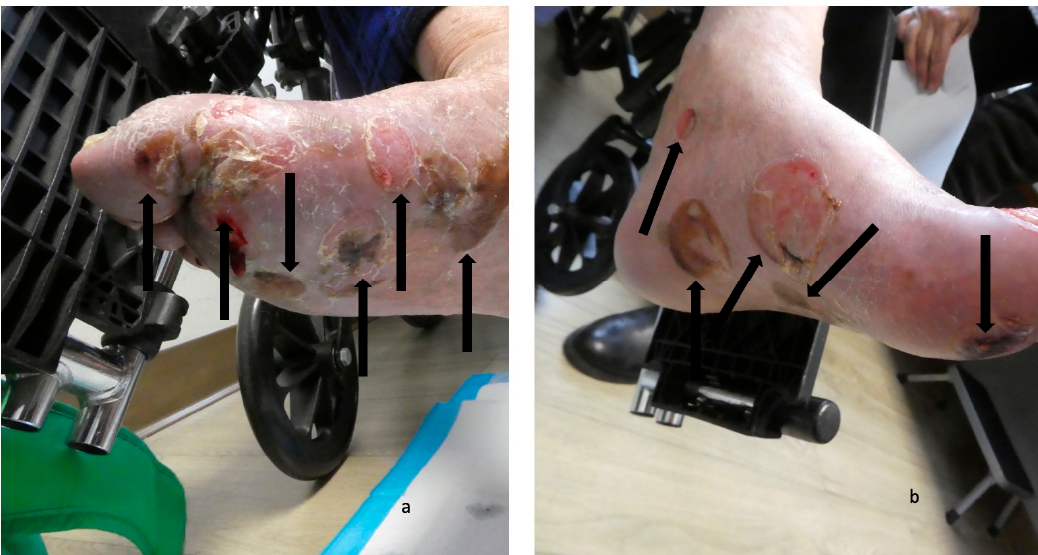
Figure 4. Blisters on the feet of a man with dyshidrosiform bullous pemphigoid. The plantar and medial surfaces of the right foot ( a ) and left foot ( b ) of a 65-year-old man with dyshidrosiform bullous pemphigoid show numerous flattened and deroofed blisters (black arrows). The figure and legend were originally published in Cureus under the Creative Commons (CC-BY): https://creativecommons.org/licenses/ on 11 January 2020 (Cohen PR: Dyshidrosiform bullous pemphigoid: Case reports and review. Cureus. 2020 Jan 11:12(1):e6630) and are republished with permission.